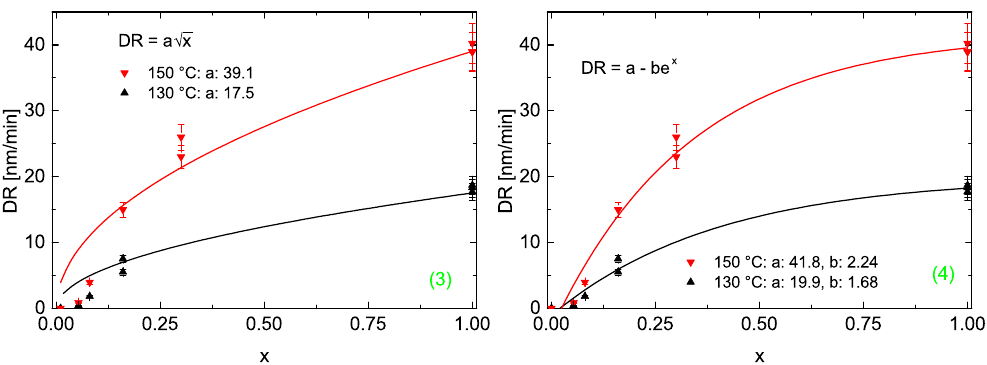
Figure 15. Deposition rate DR of parylene N as function of reactor pressure p ( 1 + 2 ), and of the molar fraction x ( x = f MPX / ( f MPX + f Ar ) ) for two models. By diluting the vapor with argon, the reaction is forced to surface polymerization (reaction of first order), best visible by the linear logarithmic slope [61]. Model ( 3 ): rate-limiting step is condensation of the monomer, model ( 4 ) due to Fortin, which includes surface diffusion as rate-limiting